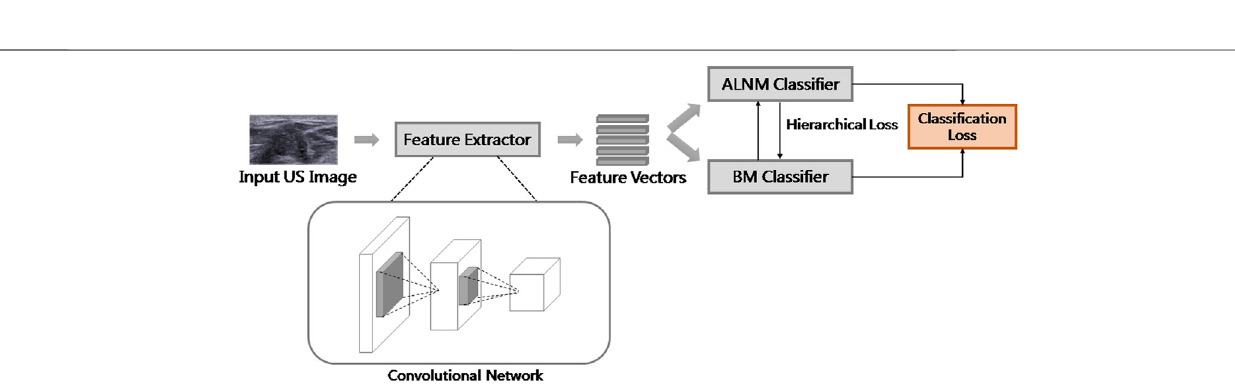
FIGURE 2 | Overall framework of our